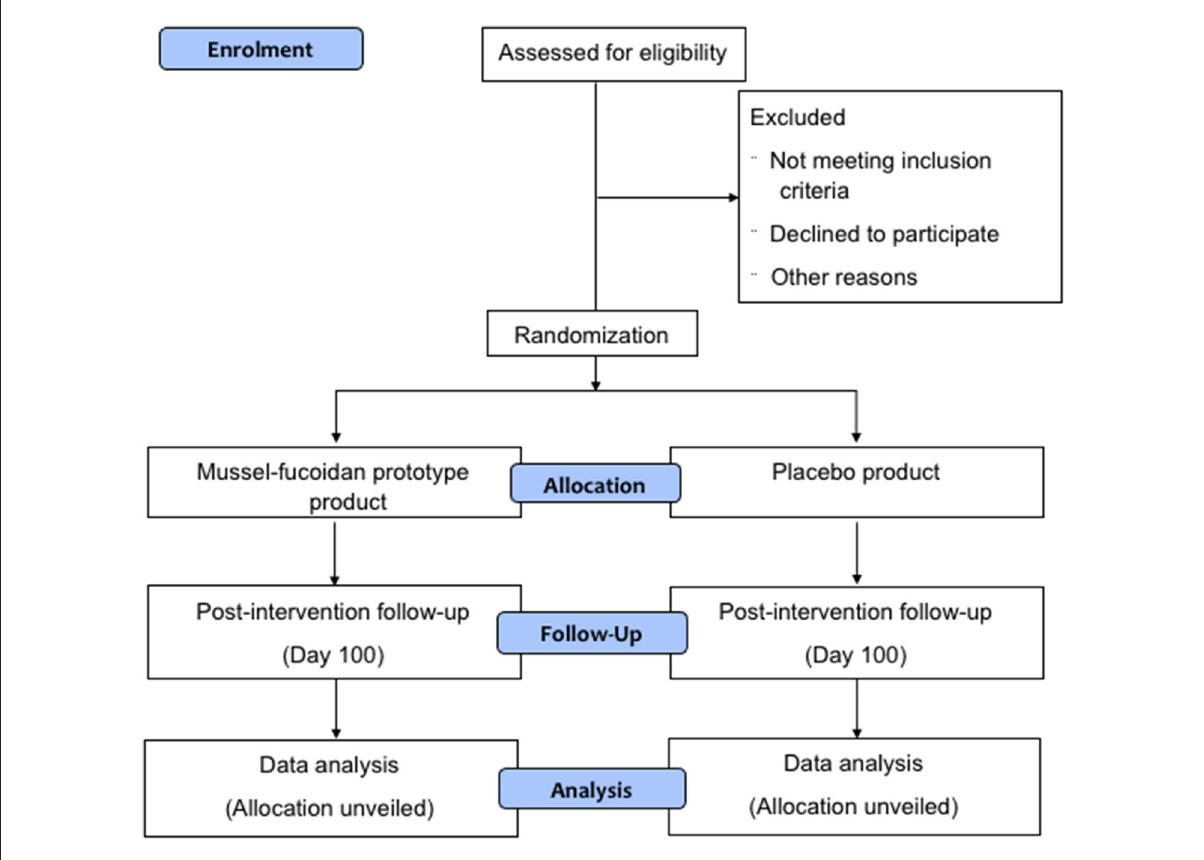
FIGURE1 CONSORT